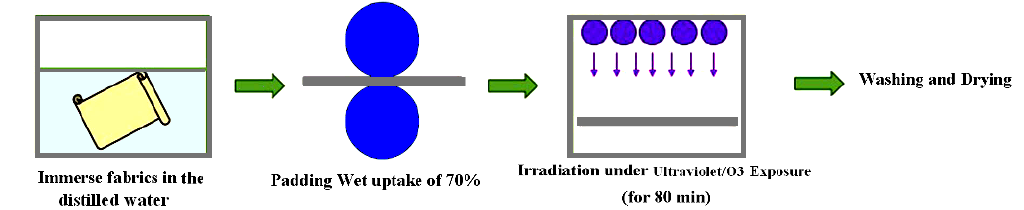
Fig. 1. Scheme of the Ultraviolet/O Figure 1: Scheme of the Ultraviolet/O